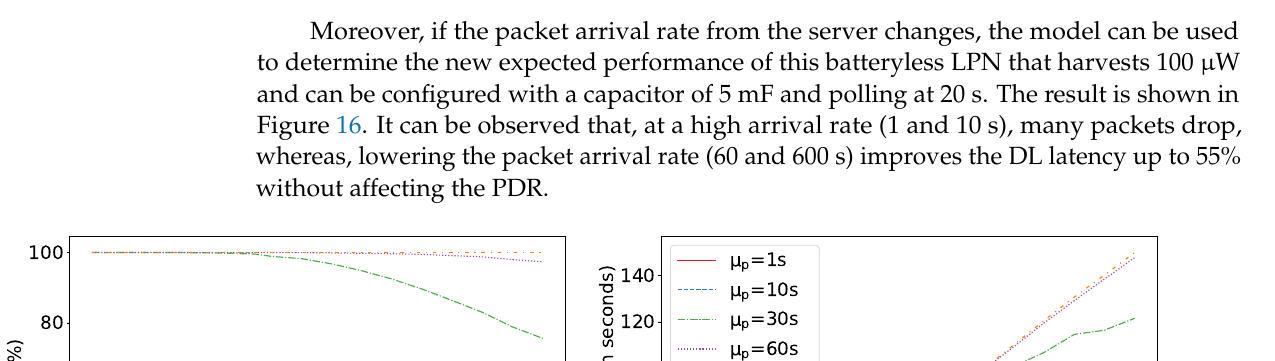
Figure 15. Asset monitoring at DR = 30 s, P h = 0.1 mW, N = 8, T AT = 5 ms. ( a ) Average packet delivery ratio; ( b ) DL latency.